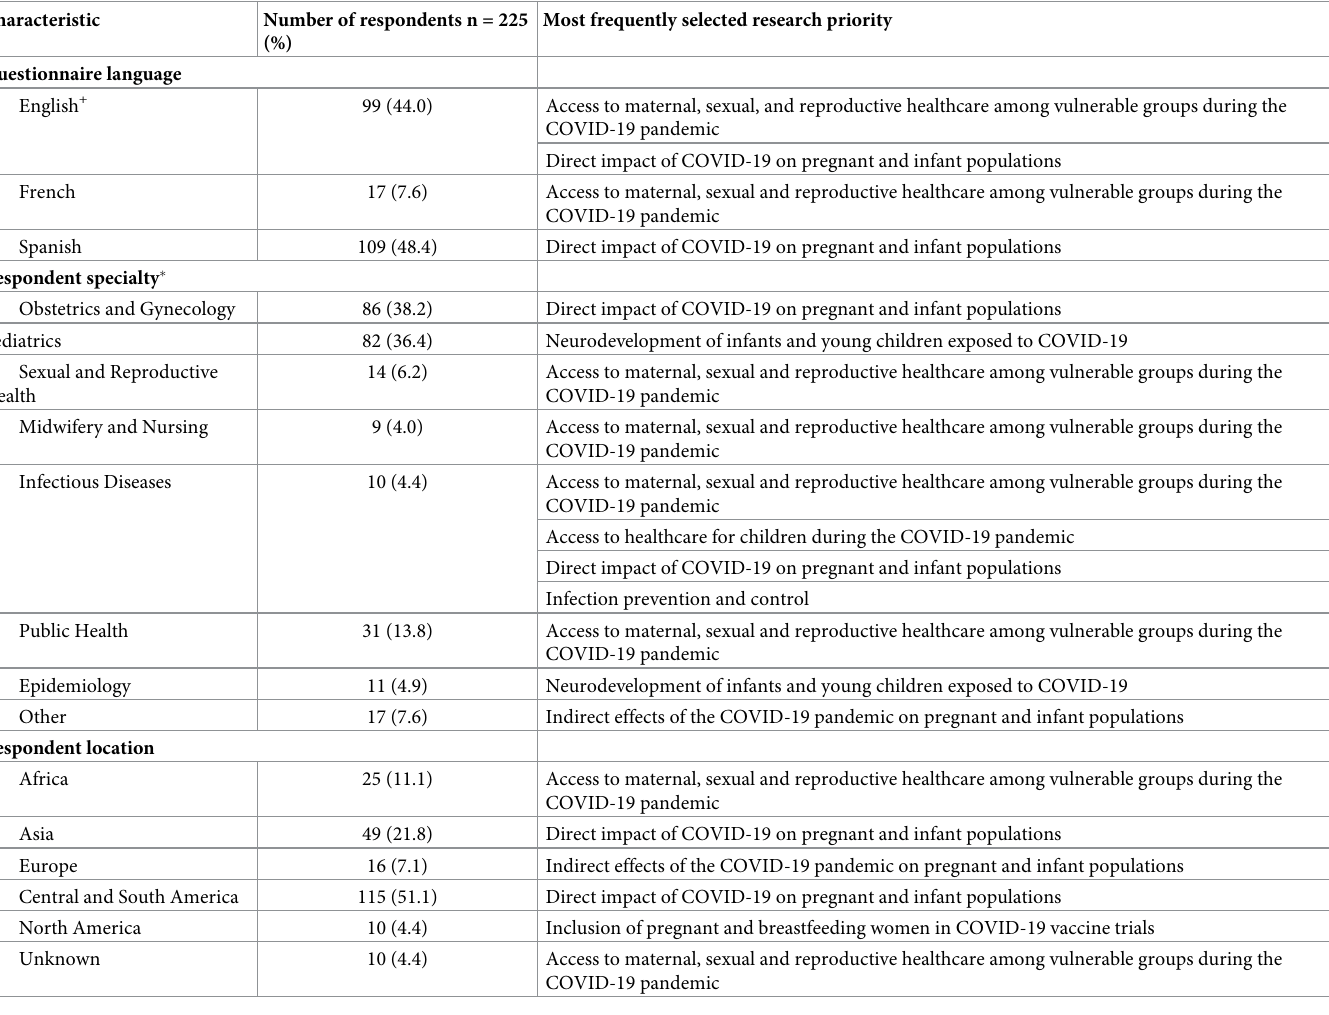
Table 1. Demographic characteristics of Questionnaire 1 respondents and the most frequently selected research priorities according to questionnaire language, respondent specialty and location.